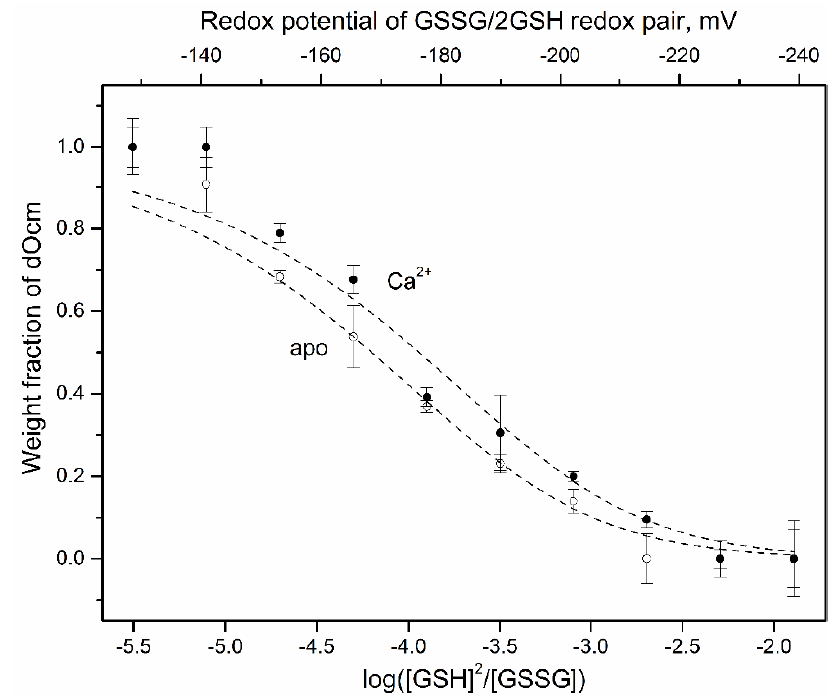
Figure 2. Quantitation of redox equilibrium between apo-/Ca 2+ -loaded dOcm and GSSG/2GSH redox couple at 35 °C. 1.5 μM dOcm solution (50 mM HEPES-KOH, 100 mM KCl, 1 mM EDTA/CaCl 2 , pH 7.4) was incubated under anaerobic conditions with 0.2 mM GSSG and 25 μM to 1.6 mM GSH for 62 h, followed by non-reducing SDS-PAGE. The weight fractions of dOcm were derived from quantitative analysis of the gels. The top axis corresponds to the redox potential of GSSG/2GSH redox pair (scheme [II]) calculated according to Equation (4). The dashed curves correspond to theoretical fits of the data computed according to scheme [I] using Equation (1).